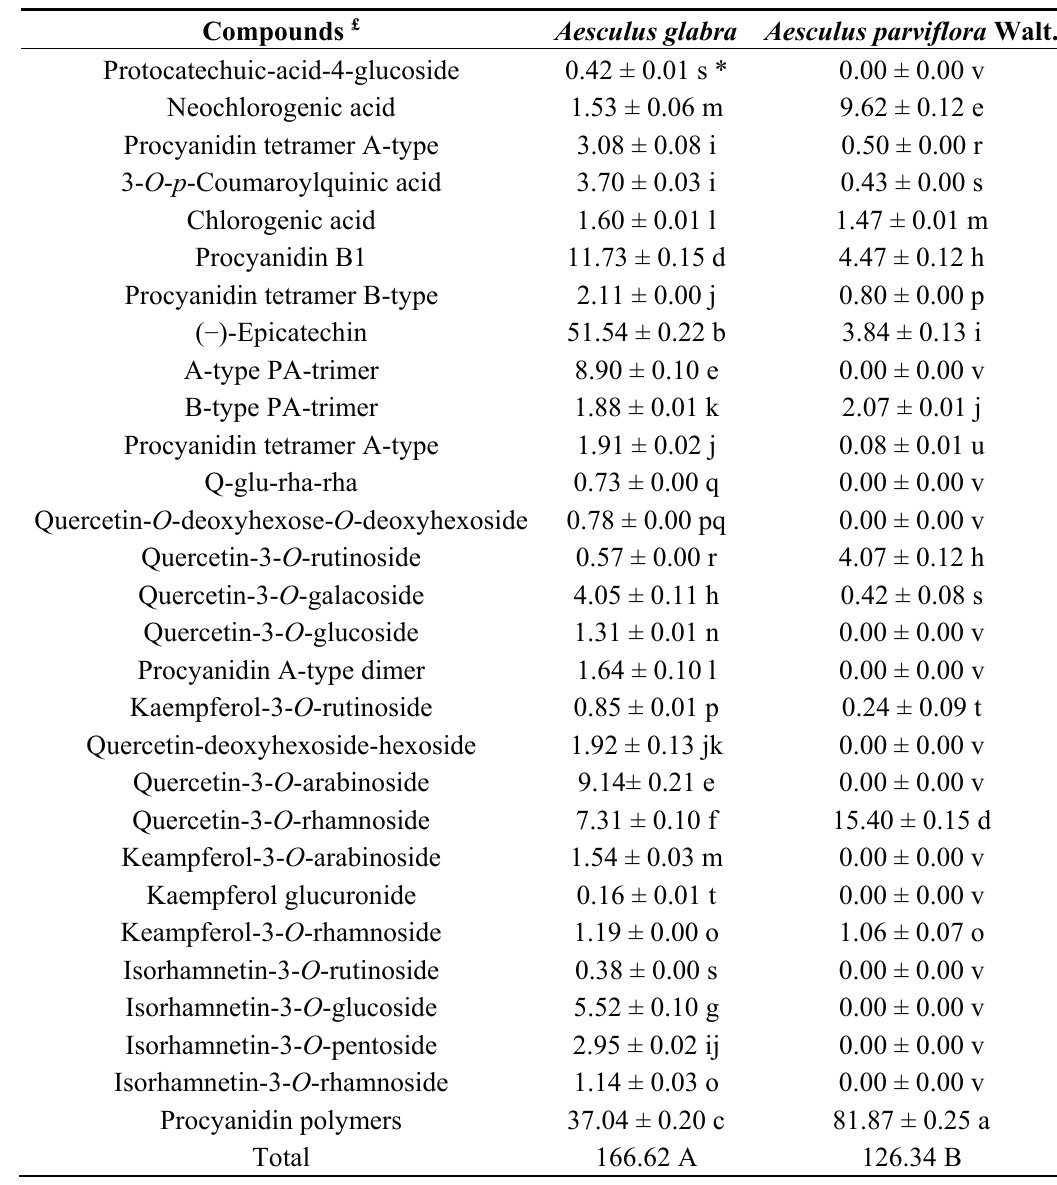
Table 2. The content (mg/g dm) of phenolic compounds of the extracts of Aesculus glabra and Aesculus parviflora Walt.